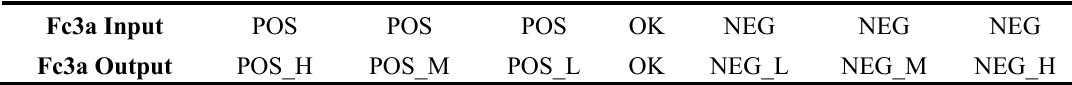
Table 1. Fuzzy Rules of the